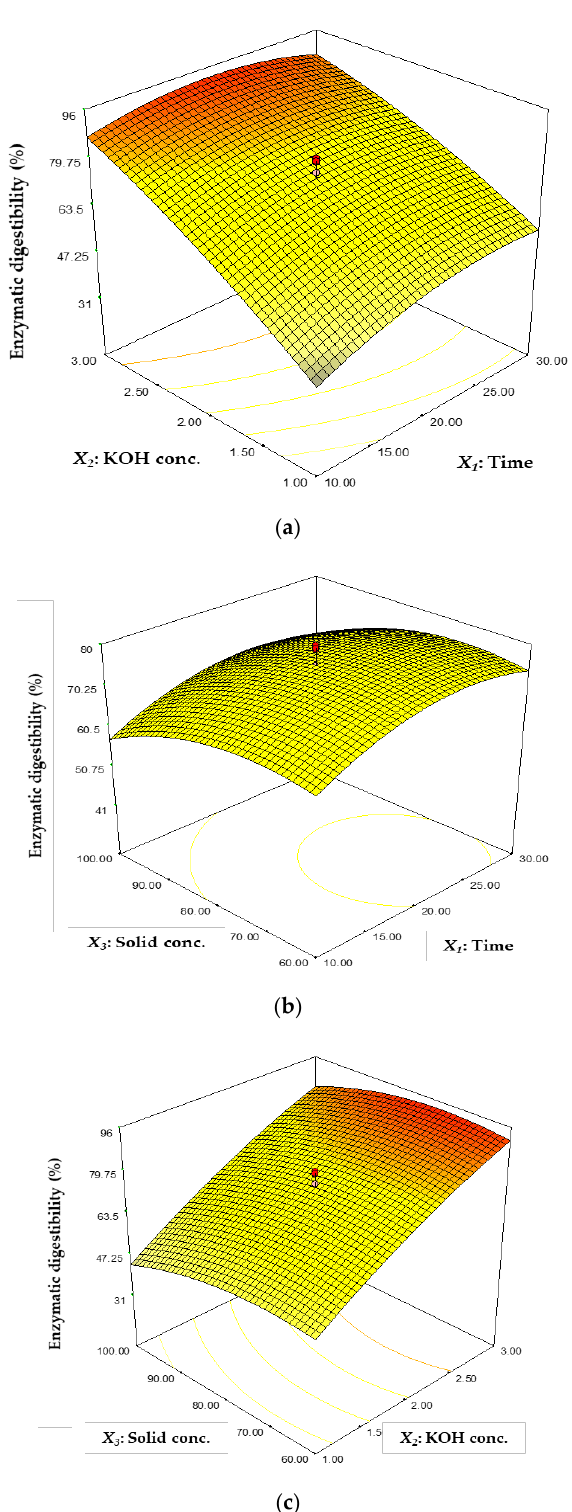
Figure 2. Three-dimensional (3D) response surfaces indicating the effects of thermal–alkaline pre- treatment variables. The effects of X 1 and X 2 on enzymatic digestibility (ED) ( a ); the effects of X 1 and X 3 on ED ( b ); the effects of X 2 and X 3 on ED ( c ). (X 1 : time, X 2 : KOH concentration and X 3 : solid